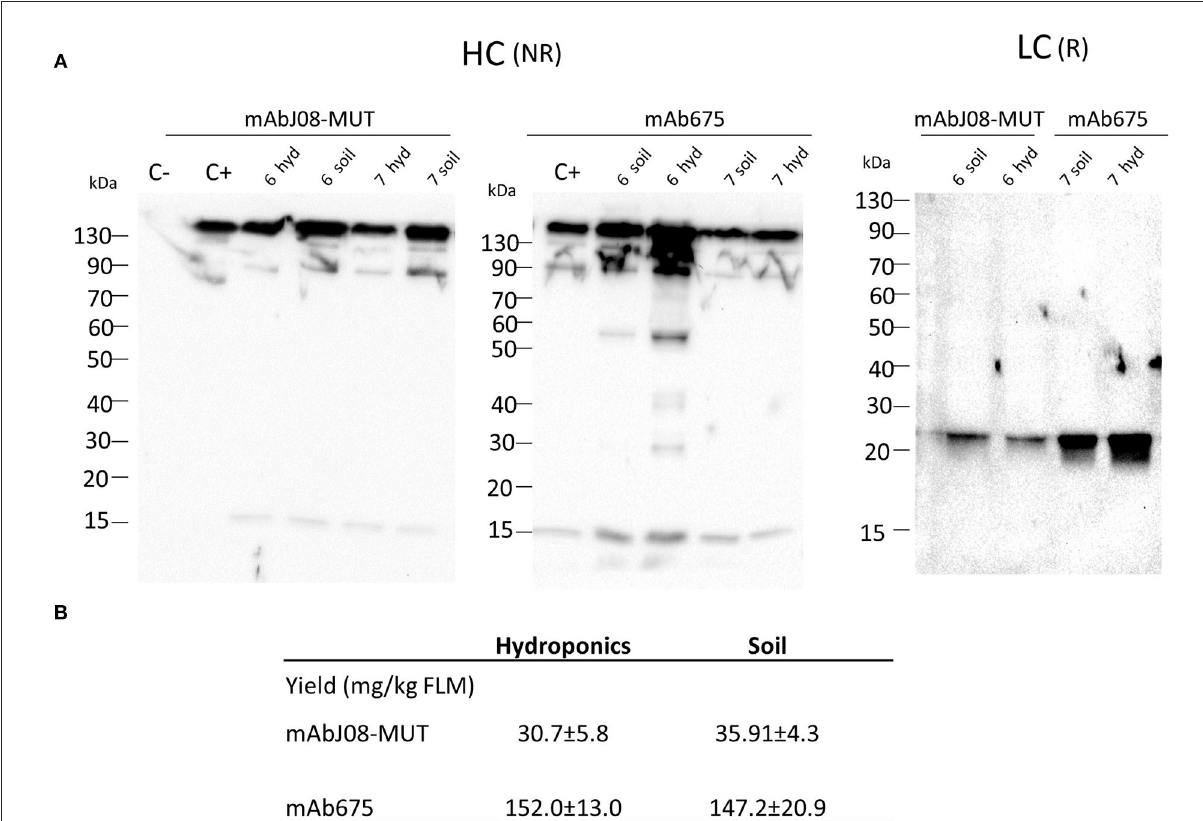
FIGURE2 Accumulation of nAbs in vacuum-agroinfiltrated plants grown in soil or in a hydroponic system. (A) Western blot analysis of vacuum-agroinfiltrated FX-KO N. benthamiana plants producing mAbJ08-MUT and mAb675. Leaves from plants grown hydroponically (hyd) on rockwool substrate or in soil (soil) were collected on day 6 or 7 post-infiltration. Extracts normalized for total soluble protein (TSP) content were separated on reducing (R) or non-reducing (NR) 12% SDS-PAGE; 10 µ g of TSP was loaded for each sample. C-: Extracts from plants infiltrated with only P19 silencing suppressor; C + : 50 ng of human IgG1 mAbRTX. Detection was performed with an anti-human γ chain (HC) or anti-human κ chain (LC) HRP-conjugated antibody. (B) Accumulation yield per kg of fresh leaf mass (FLM) of nAbs was calculated by quantitative double-antibody sandwich ELISA; reported values are the mean ± standard deviation (SD) ( n = 3). Values of samples mAbJ08-MUT Hydroponics, mAbJ08-MUT Soil, mAb675 Hydroponics, and mAb675 Soil had coefficient of variations of 18.93, 12.02, 8.57, and 14.2%, respectively. P < 0.05 for mAbJ08-MUT Hydroponics compared to mAb675 Hydroponics and for mAbJ08-MUT Soil vs. mAb675 Soil. No significant difference was found for mAbJ08-MUT Hydroponics vs. mAbJ08-MUT Soil and mAb675 Hydroponics vs. mAb675 Soil